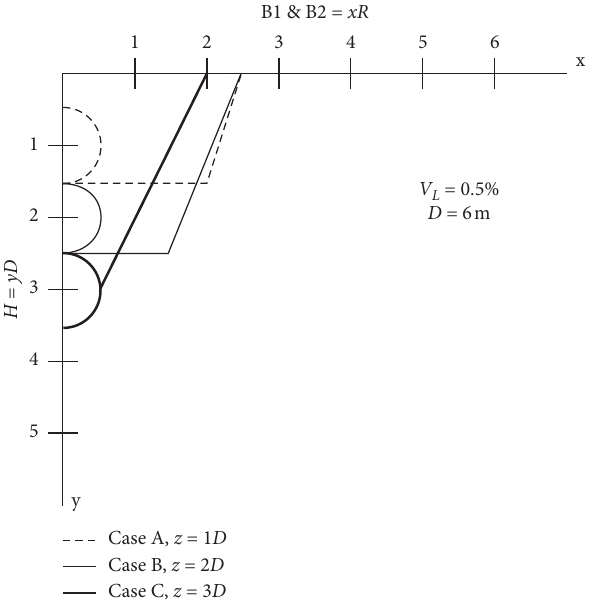
Figure 6:10mm settlement contour for different tunnel depths. Three cases A, B, and C for placing depths of tunnel at its sizes or diameter “ D